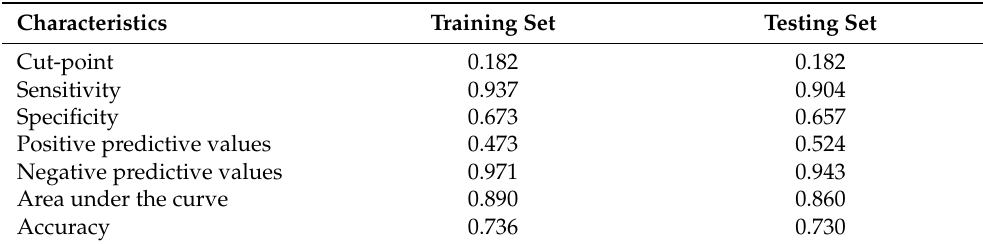
0.74 and 0.73, respectively. Table 4. Screening performance characteristics of the model in the training and testing